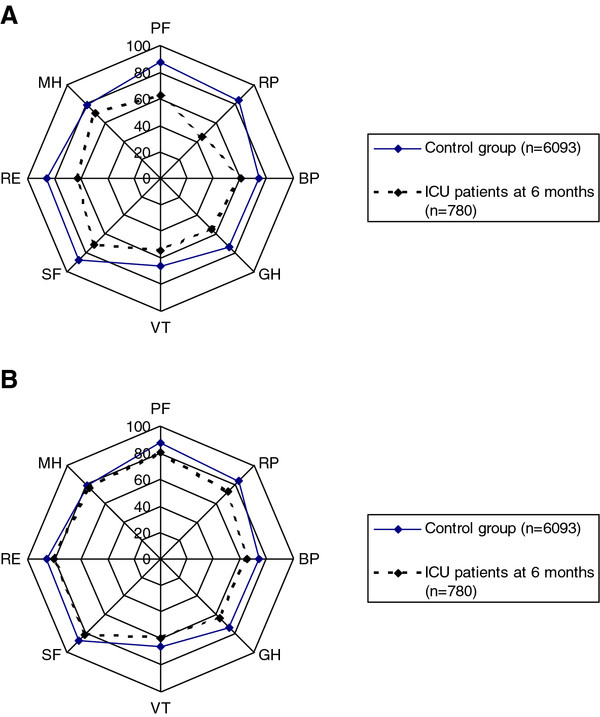
Health-related quality-of-life differences between the reference group and ICU patients not adjusted for age and sex respectively adjusted for age and sex. (A) Health-related quality of life (SF-36) values shown for each dimension: physical functioning (PF), role limited by physical problems (RP), bodily pain (BP), general health (GH), vitality (VT), social functioning (SF), role limited by emotional problems (RE), and mental health (MH) in the Polar Plot Chart for the reference group (n = 6,093) and patients from ICU (n = 780), not adjusted for age and sex. (B) Health-related quality of life (SF-36) values shown for each dimension: physical functioning (PF), role limited by physical problems (RP), bodily pain (BP), general health (GH), vitality (VT), social functioning (SF), role limited by emotional problems (RE), and mental health (MH) in the Polar Plot Chart for the reference group (n = 6093) and patients from the ICU (n = 780), adjusted for age and sex.